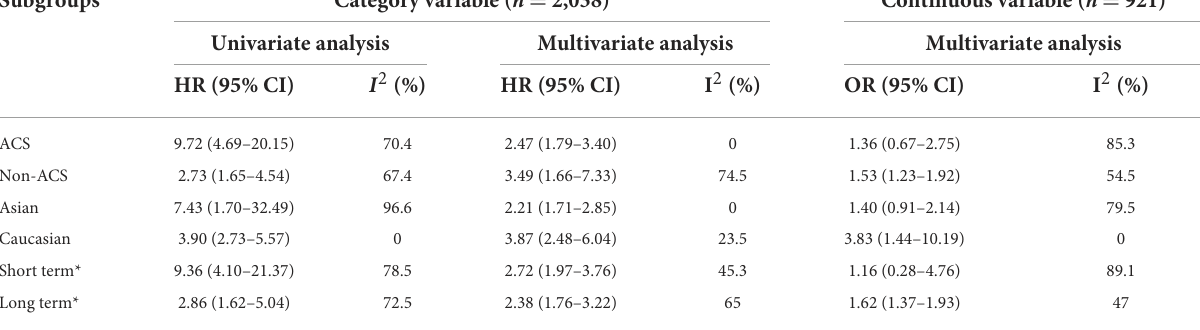
TABLE 2 Subgroup analysis stratified by CAD type, ethnicity, and follow-up duration.